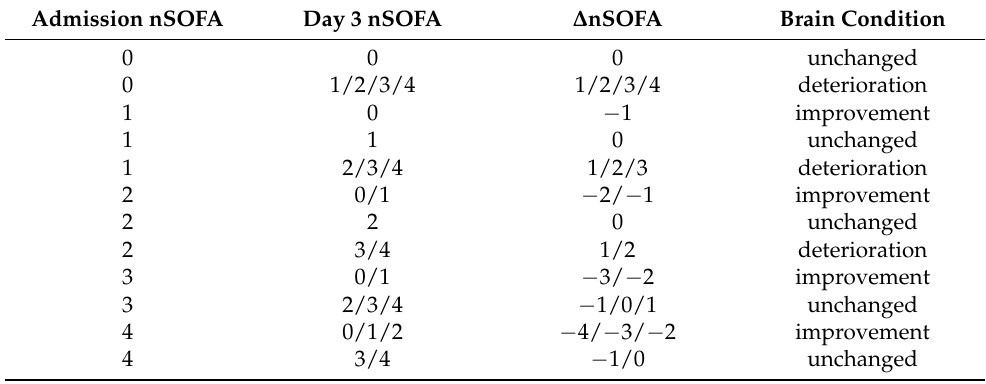
Table 1. Definitions of brain function according to changes in neurological sequential organ failure assessment ( ∆ nSOFA) score from admission to day